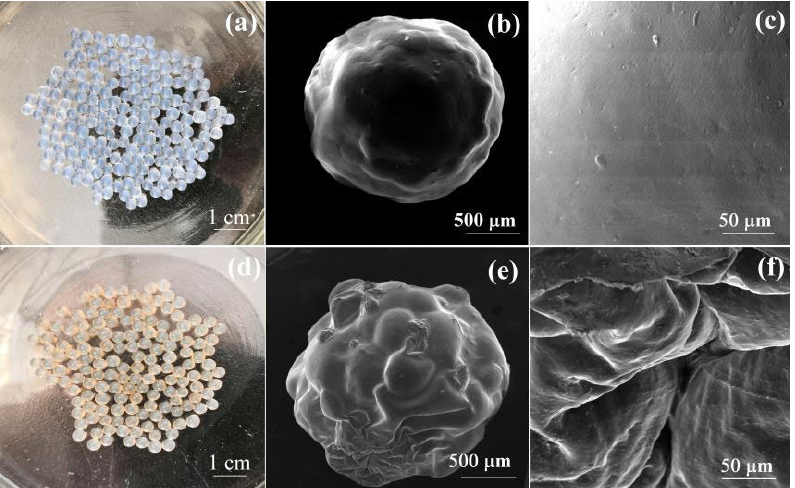
Figure 2. Photos of SA beads ( a ) and Tan/SA ‐ 40% beads ( d ), SEM images of SA beads ( b , c ), Tan/SA ‐ 40% beads ( e , f